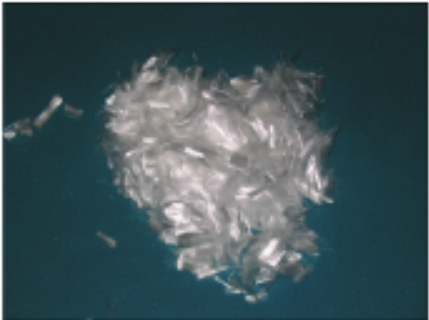
Figure 1: The polypropylene fiber.